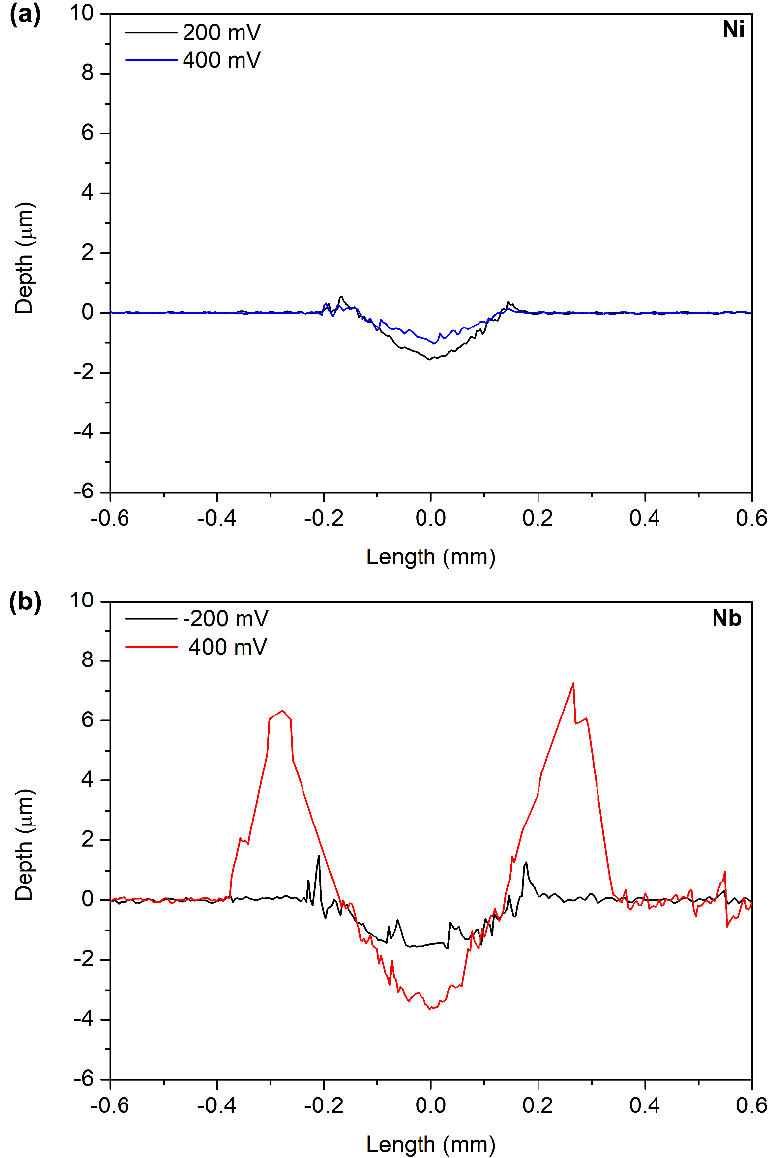
Figure 5. The wear track profiles of ( a ) Ni and ( b ) Nb after the potentiostatic tribocorrosion tests. Figure 6a to c were the SEM images of Ni after the PSTT with 200 mV. The worn surface was covered by a film that was formed under the combination of electrochem- ical and mechanical actions and called a tribo-film [26,27]. It was proved that the tribo-film was formed on the passive film [3,28]. Some scratches that were parallel to the sliding direction were found on the tribo-film. Parts of the film had been re- moved. The region that lost the coverage of the tribo-film showed huge plastic